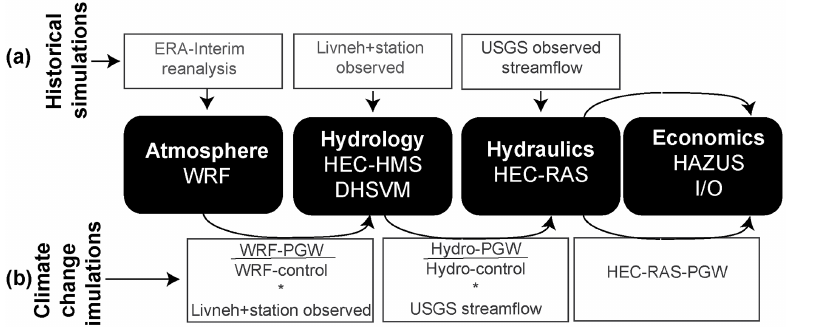
Figure 2. Diagram of the integrated modeling, including the models used and the input data for each model during the historical simulations (a) and the climate change simulations (b) . Hydro-control represents both HEC-HMS and DHSVM-control simulations, while Hydro-PGW represents both HEC-HMS and DHSVM-PGW